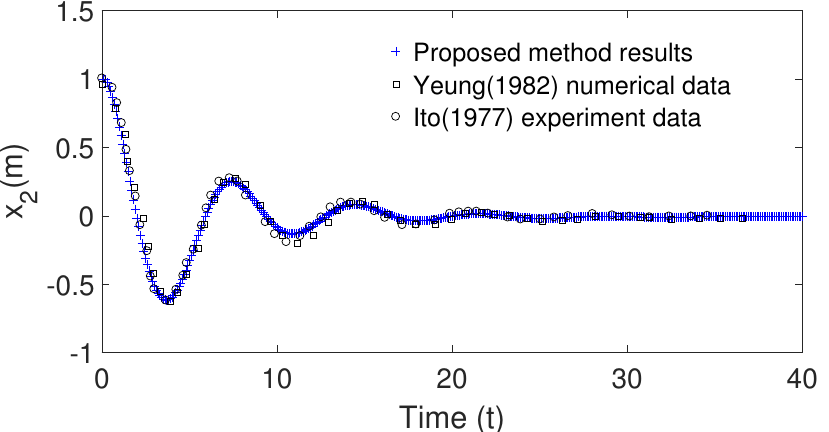
Figure 5. Comparison of heave decay test for the semi circular cylinder between proposed method results, [31] numerical results and [32] experimental data.